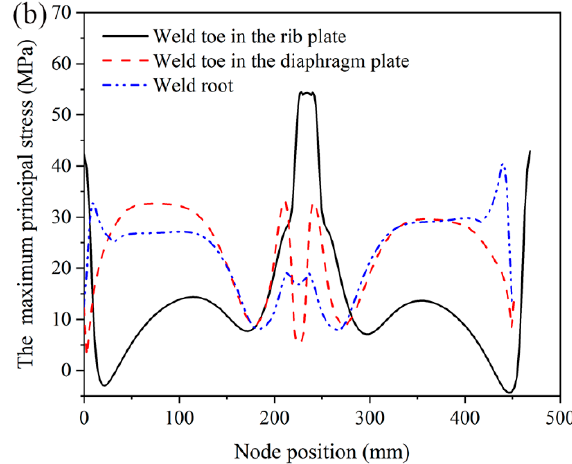
Figure 15. ( a ) Reinforcing plates in improvement scheme 3 and ( b ) stress—node position curves of the rounded welding region.